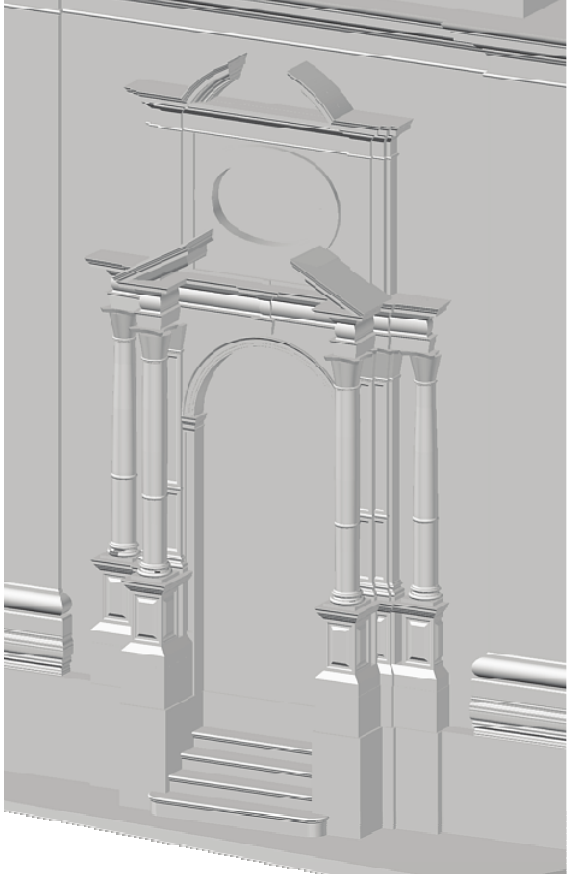
Figure 13. Detailed view of the baroque portal of Anime Sante’s church geometric